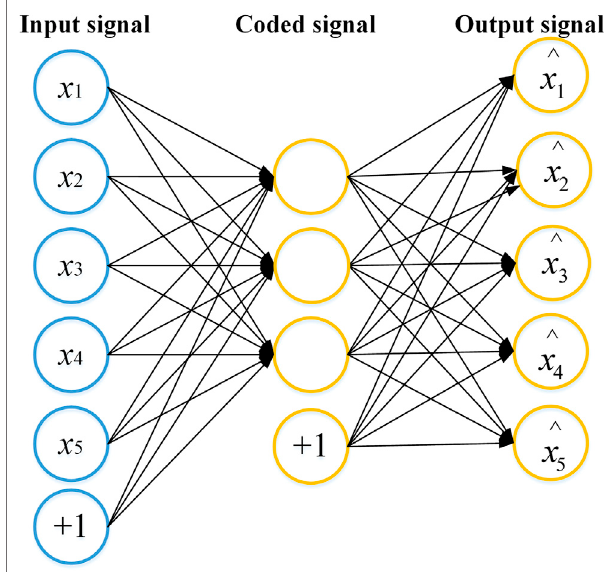
FIGURE1| Thenetworkstructureoftheautoencoder.Theautoencoder consists of an encoder and a decoder. The encoder converts an input signal into a coded signal, and the decoder converts the coded signal into an output signal. The output signal reproduces the raw input signal as much as